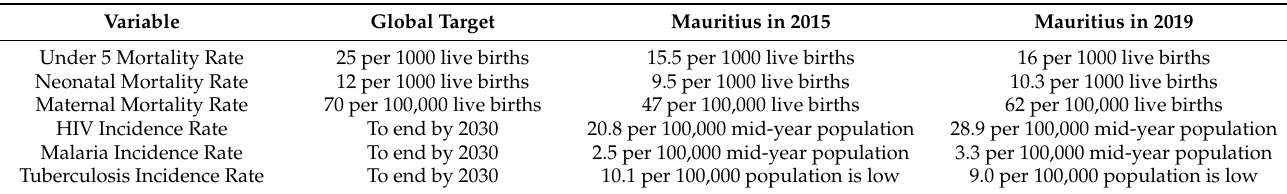
Table 1. Sustainable Development Goals 2030.